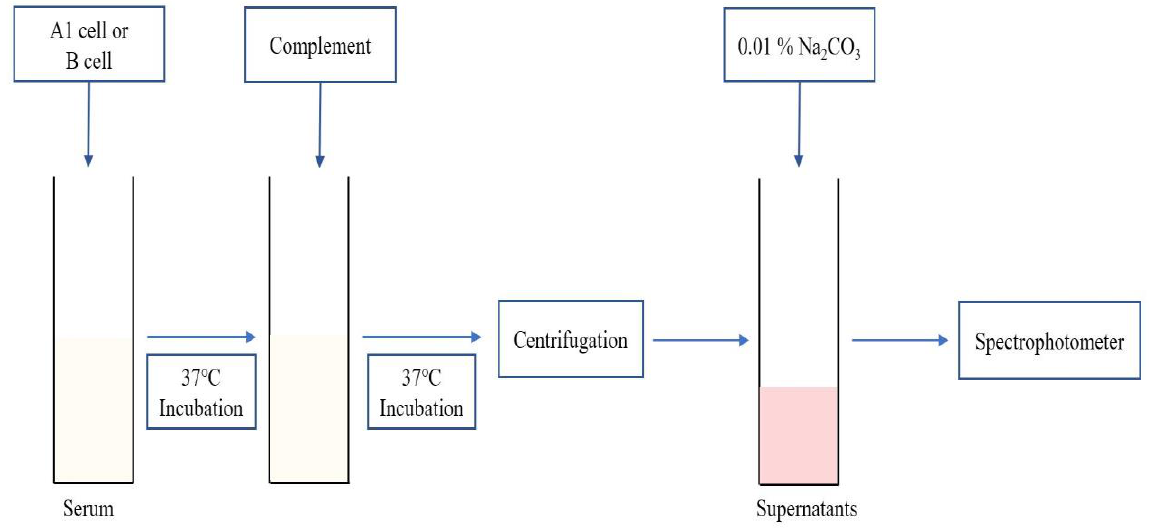
Figure 1. Schematic representation of the plasma Hb level measurement method.